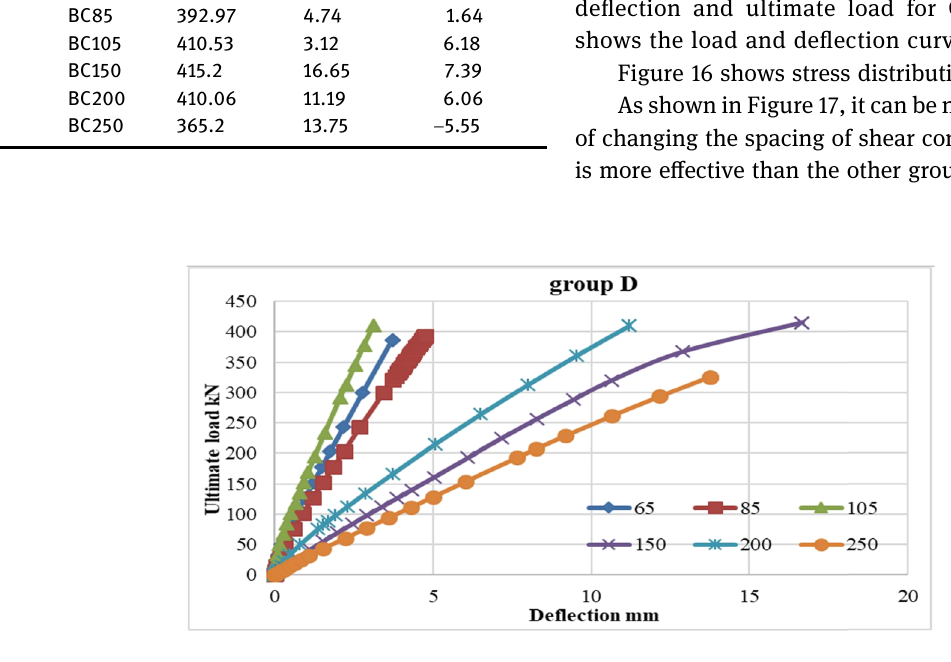
Figure 15: Load – de fl ection for the specimens of Group